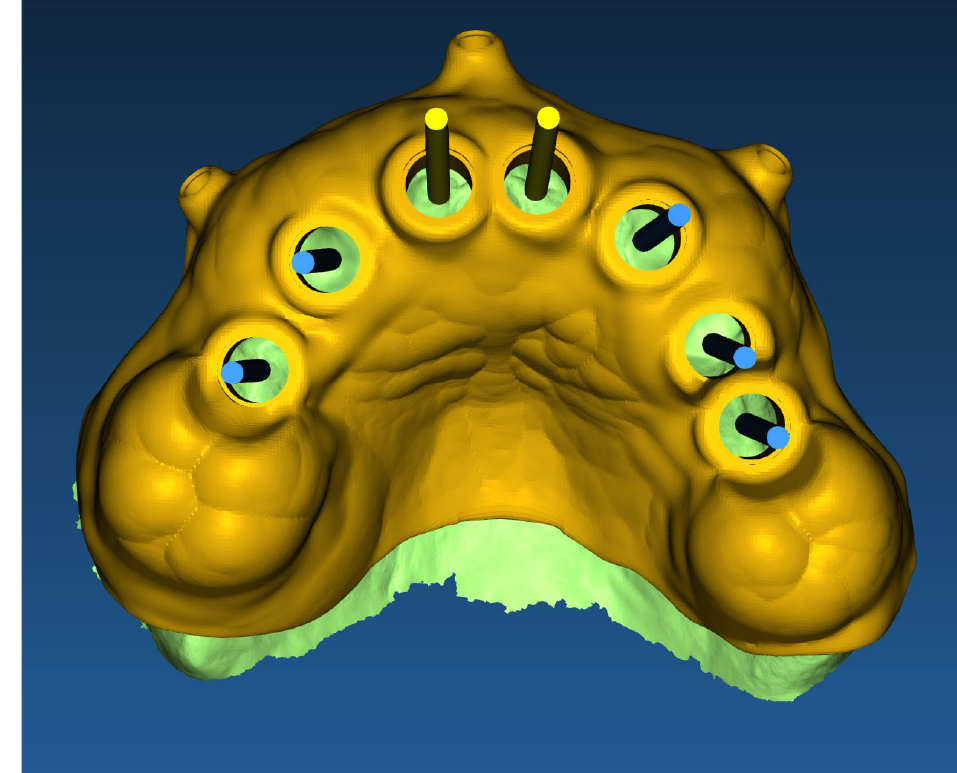
Figure 4. Virtual design of the surgical template.